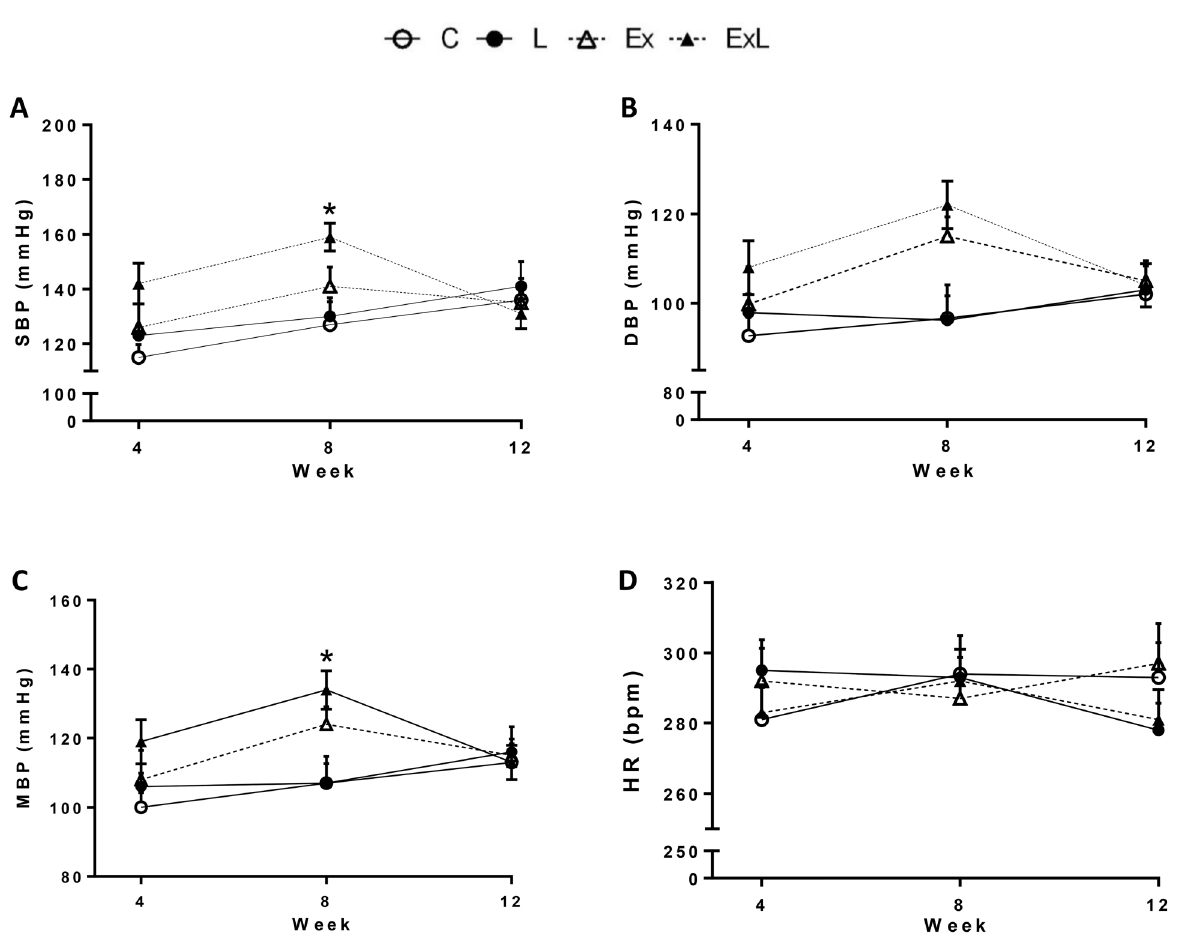
Figure 3. Blood pressure responses and heart rate during 12 weeks of experimental protocol. C: Control (n=8); L: low-dose administration of L-NAME (n=7); Ex: chronic aerobic exercise (n=6); ExL: chronic aerobic exercise and low-dose administration of L-NAME (n= 6). A , SBP: systolic blood pressure; B , DBP: diastolic blood pressure; C , MAP: mean arterial pressure; D , HR: heart rate. Data are reported as mean ± SEM. *P o 0.05, ExL vs L (two-way ANOVA followed Tukey ’ s post-hoc